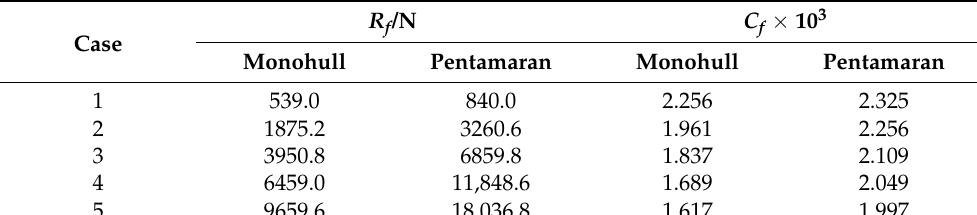
Table 10. Calculation results of pressure resistance.